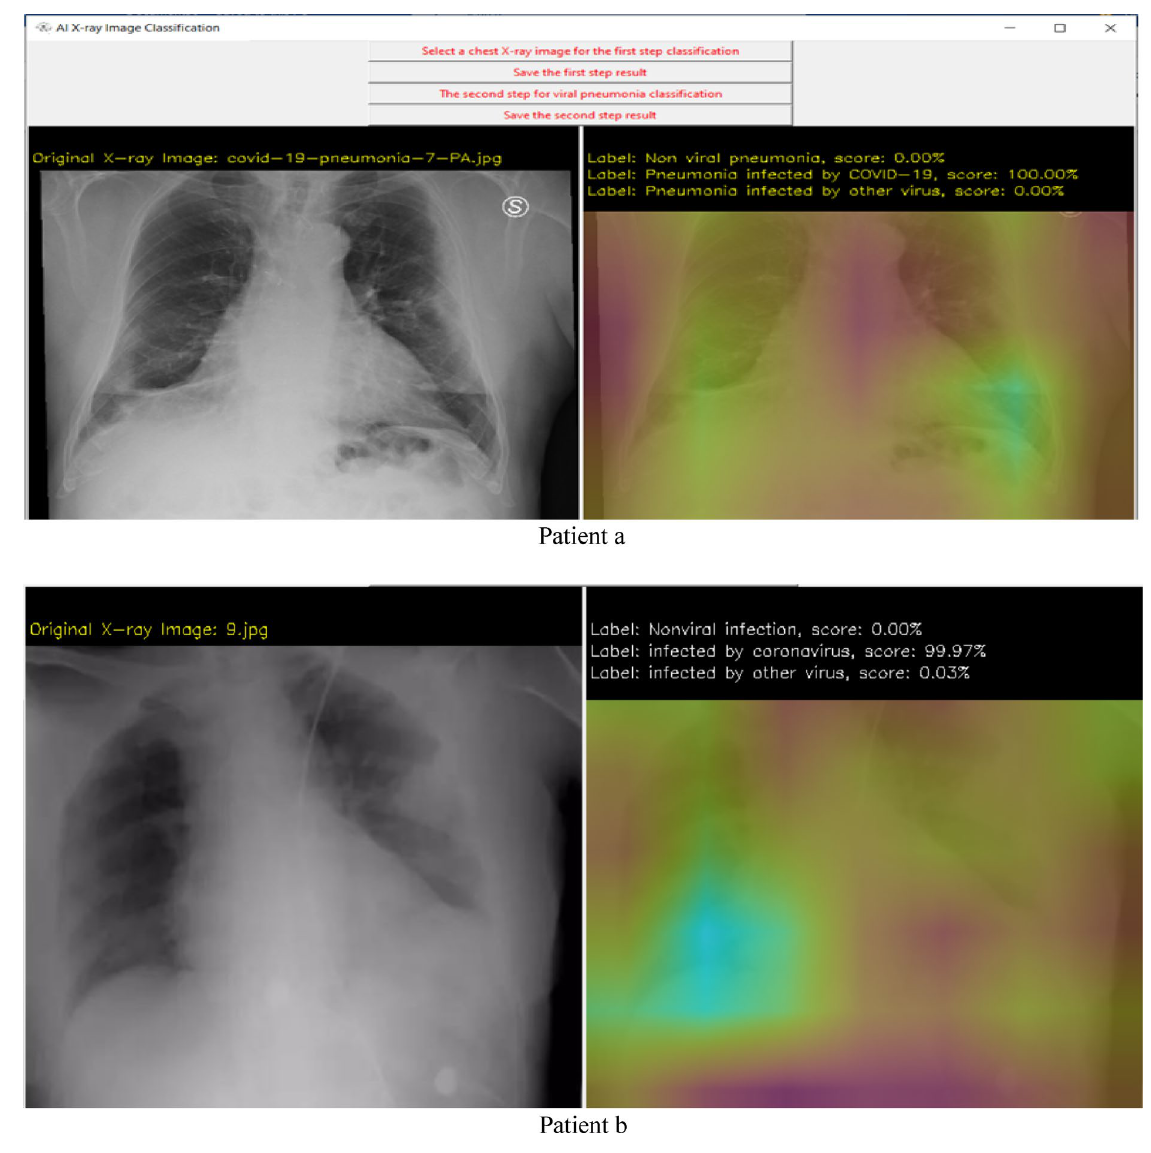
Figure 5. Analysis results